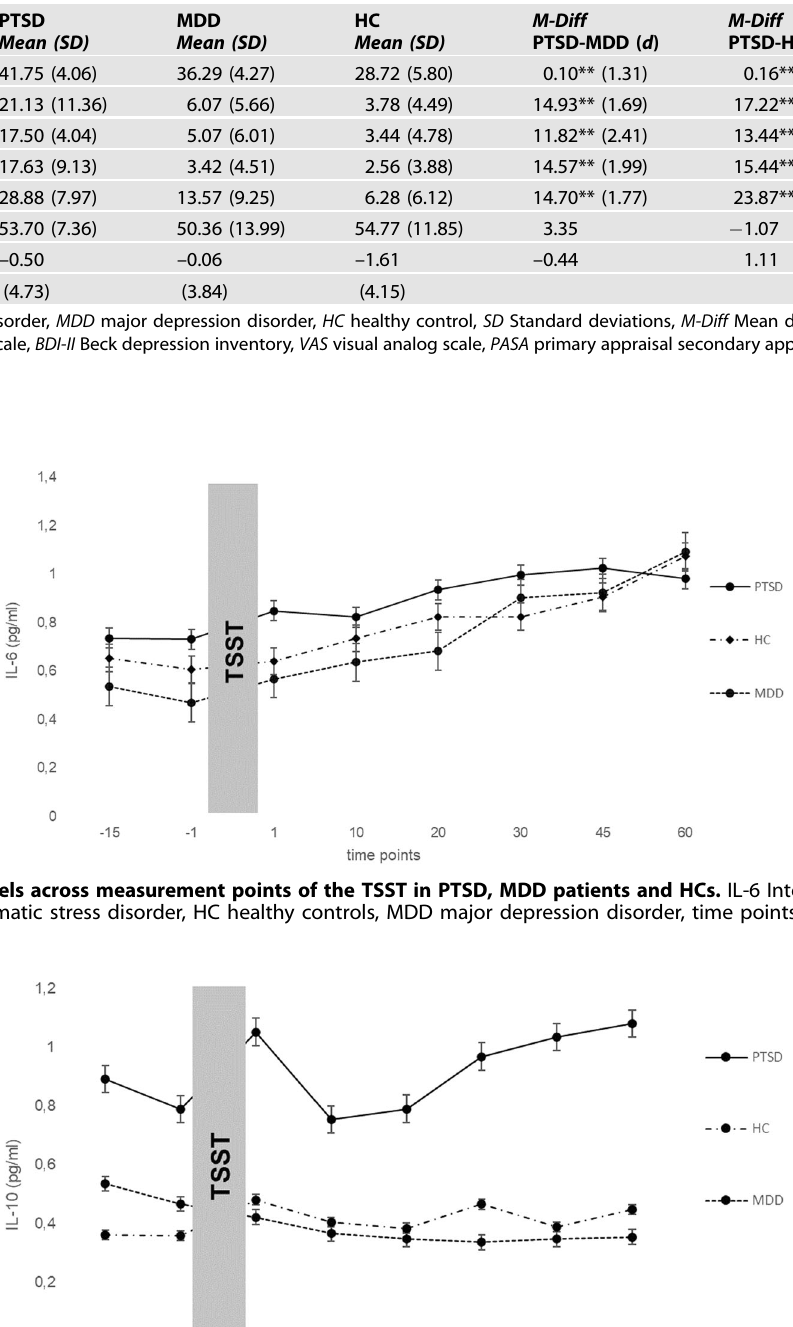
Table 1. Means, standard deviations of questionnaire data and differences between groups (ANOVA with Post hoc-tests, Bonferroni corrected).